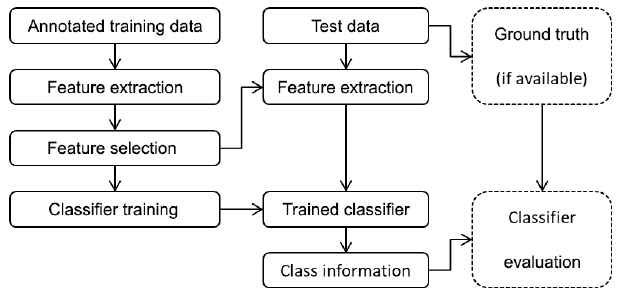
Figure 6. Block diagram of the proposed